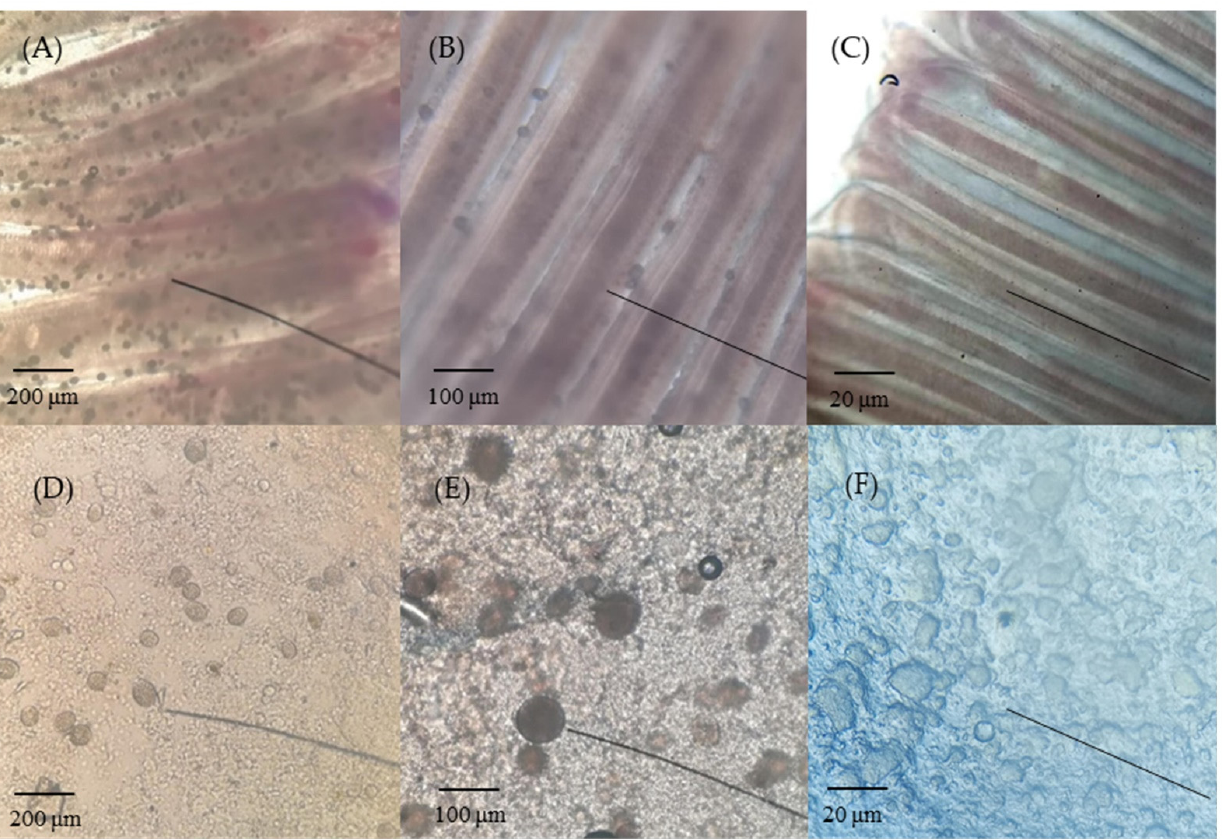
Figure 1. Gill and skin mucus of AO-infected greenfin horse-faced filefish. ( A ) Gills showing severe infection (40 ×); ( B ) gill tissues of AO-infected (100 ×); ( C ) gill tissues of control (40 ×); ( D ) skin showing severe infection (40 ×); ( E ) skin tissues of AO-infected (100 ×); and ( F ) skin tissues of control (40 ×). Bars = 200 μ m ( A , D ), 100 μ m ( B , E ), and 20 μ m ( C , F ). Table 1. Summary of the greenfin horse-faced filefish transcriptome